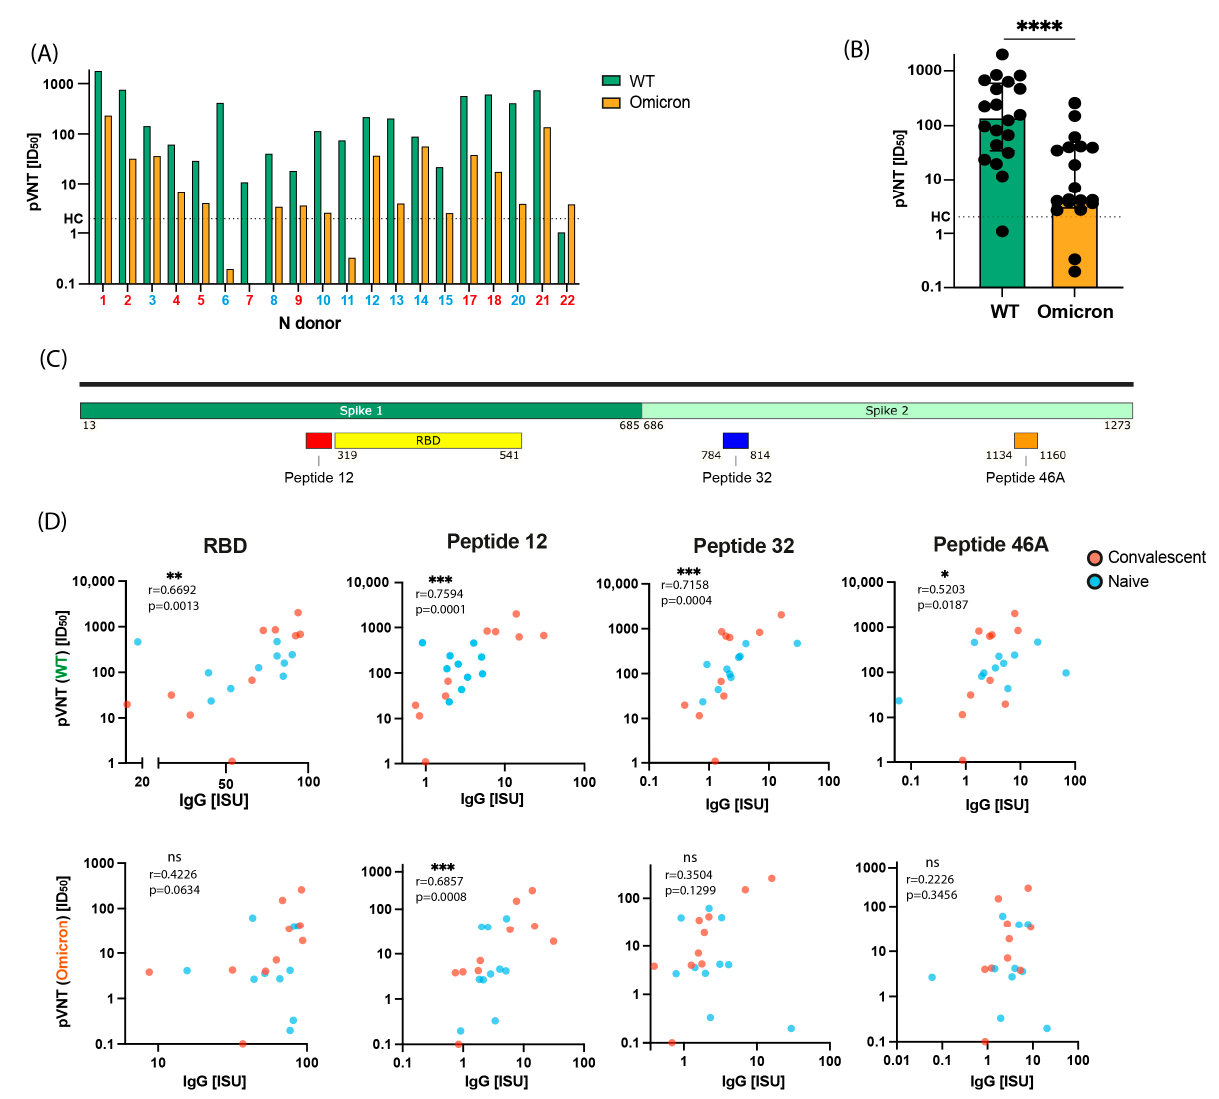
Figure 2. Virus-neutralizing activity in plasma 3 months after Sputnik-V vaccination and association with IgG antibody responses to RBD and S-derived peptides. ( A ) Virus neutralization (ID 50 ) ( y -axis) against Wuhan-hu-1 strain (green) and Omicron (orange) obtained with plasma from naïve (blue) and convalescent (red) subjects ( x -axes). ( B ) Comparison of virus neutralization ( y -axis: ID 50 obtained for plasma from the tested subjects, bars represent medians with interquartile range (IQR) Wuhan-Hu-1 (green) and Omicron (orange). The horizontal line represents results obtained with plasma from a healthy, non-infected control subject (healthy control, HC). Significant differences between strains were determined by Mann–Whitney test: **** p < 0.0001. ( C ) Localization of RBD and peptides correlated with virus neutralization in a scheme of S (S1, S2). ( D ) Correlations between virus neutralization titers for Wuhan-Hu-1 (WT) or Omicron (y-axes) and IgG levels specific for RBD and spike-derived peptides 12, 32, and 46A (x-axes: ISU). Blue and red symbols indicate naïve and convalescent subjects, respectively. Asterisks indicate significant correlations according to nonparametric Spearman test, * p < 0.05, ** p < 0.01, *** p < 0.001 **** p < 0.0001, ns = not significant.